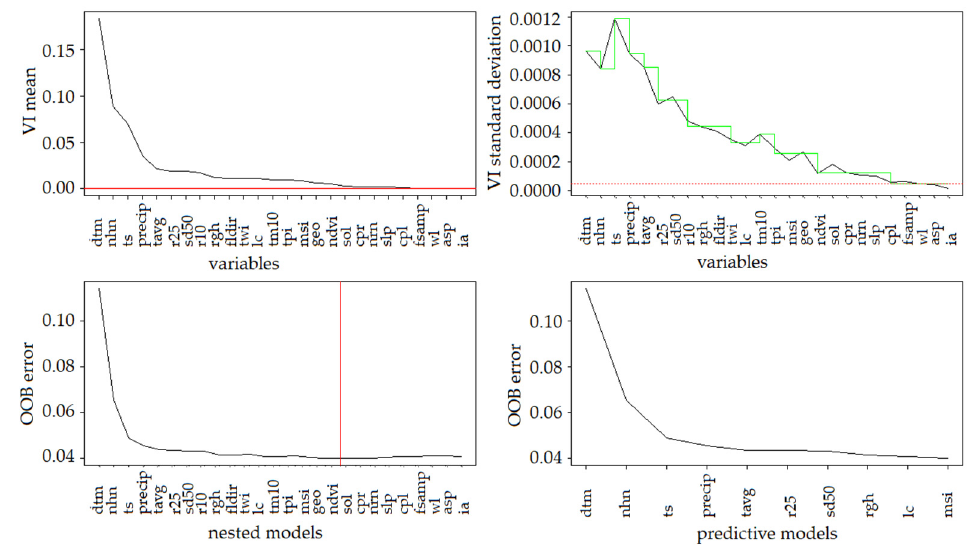
Figure 5. HG-8M variables of importance, NB. Upper left , mean variable importance, upper right : standard deviation of the variable importance, bottom left : mean OOB error rate of interpretation step of RF models, bottom right : mean OOB error rate of prediction step of RF models. Red lines indicate thresholds. The green line represents predictions given by a CART tree fitted to standard deviations.